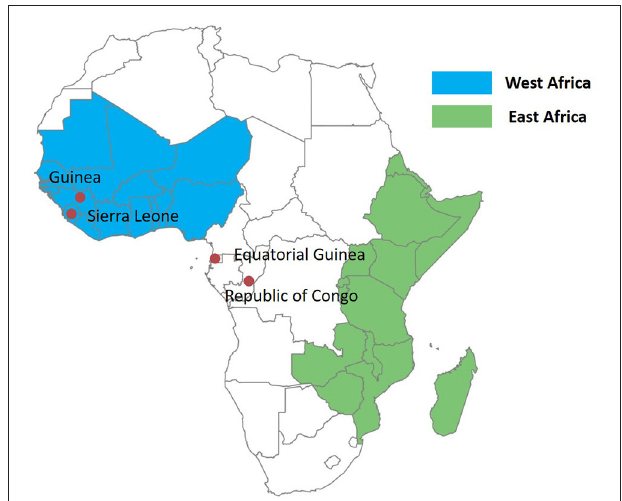
FIGURE 1 | Map of Africa showing the countries where Plasmodium falciparum isolates were imported from: Equatorial Guinea ( n = 29), Guinea ( n = 1), the Republic of Congo ( n = 1), Sierra Leone ( n =